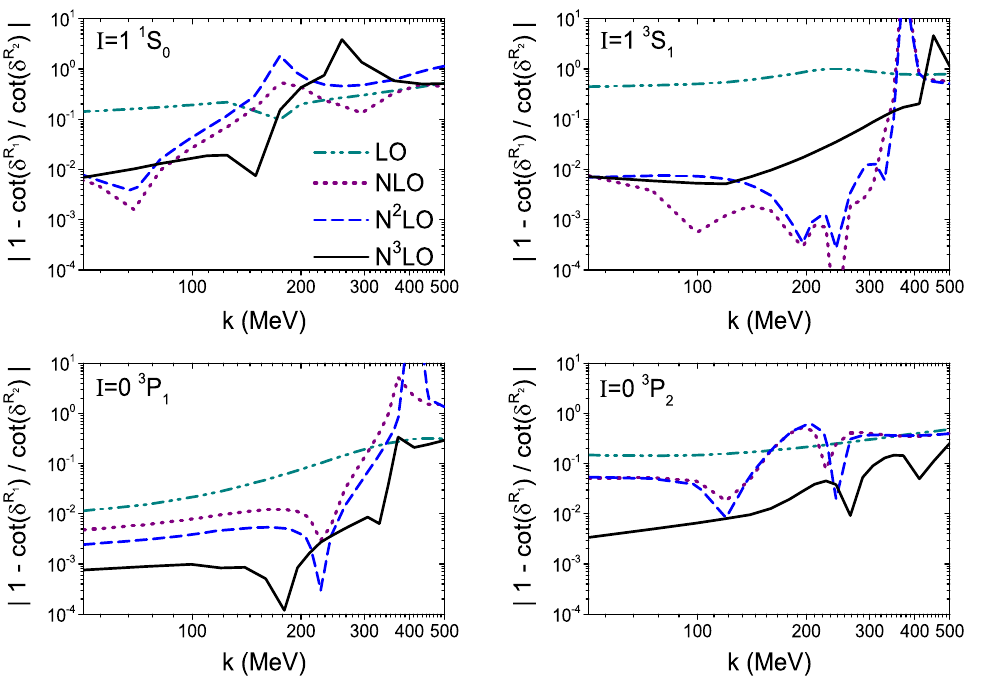
Figure 5 . Error plot for the real part of the phase shifts for the isospin I = 1 partial waves 1 S 3 S 3 P 3 P 0 , 1 and for the I = 0 1 , 2 partial waves. Here R 1 = 0 : 9 fm and R 2 = 1 : 0 fm. The black/solid line is at N 3 LO, the blue/dashed line at N 2 LO, the magenta/dotted line at NLO, and the green/dash-double-dotted line corresponds to the LO